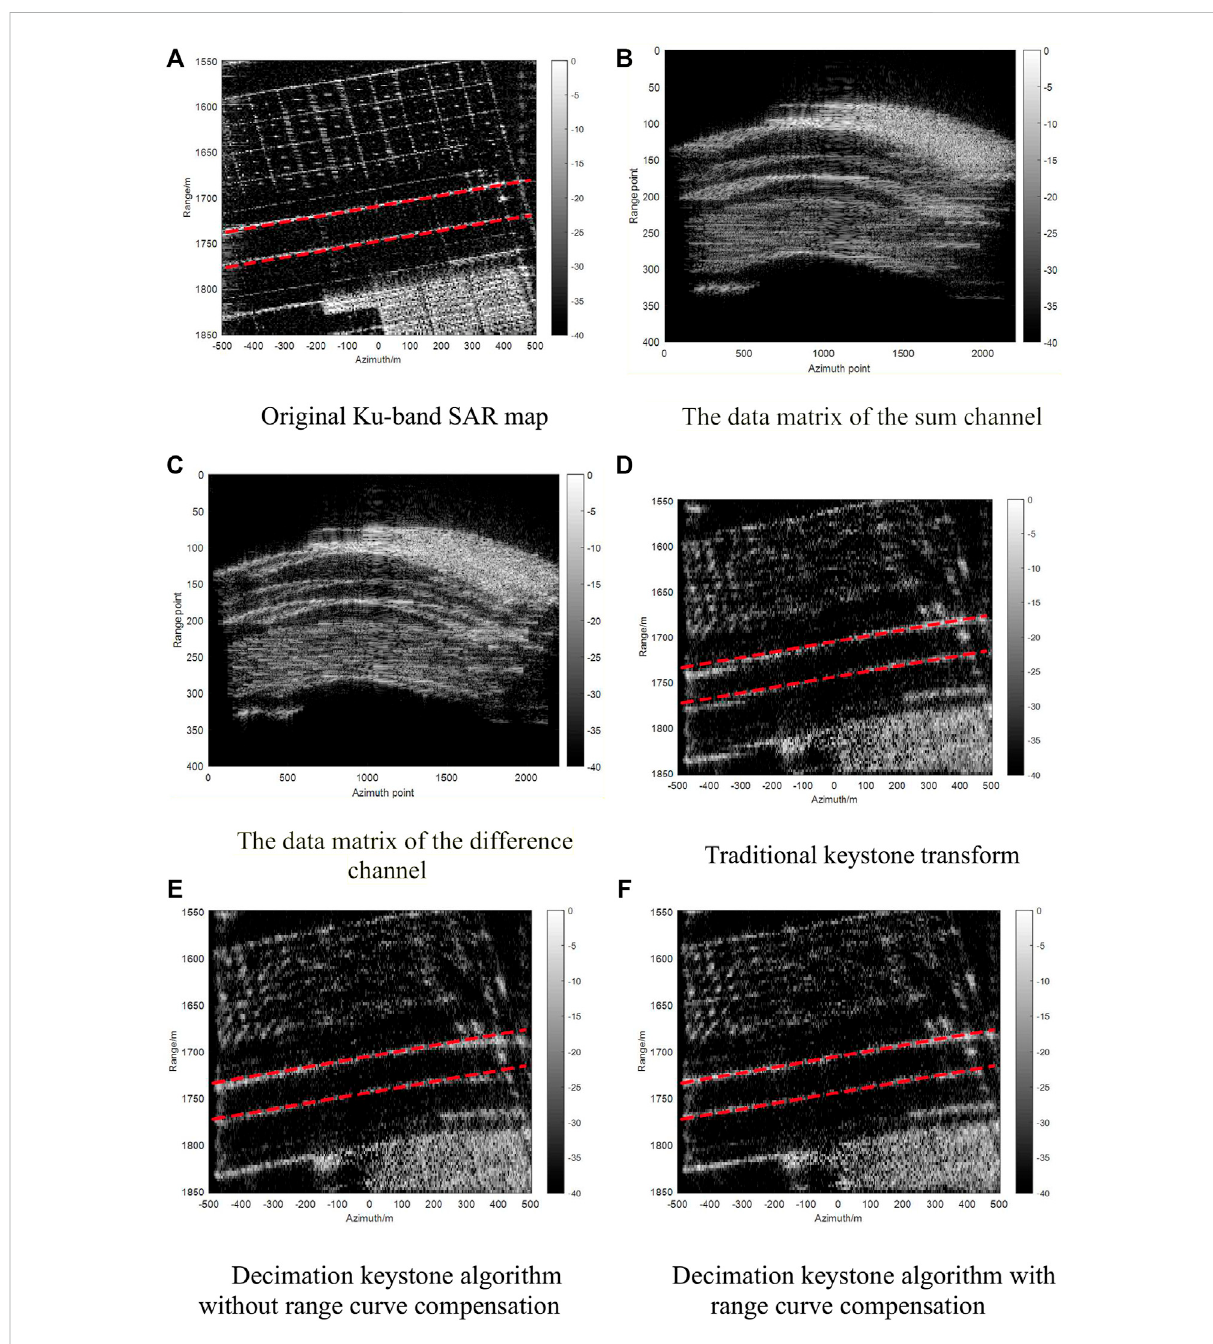
FIGURE 8 Comparison of correction results in simulation scenes. (A) Original Ku-band SAR map. (B) The data matrix of the sum channel. (C) The data matrix of the difference channel. (D) Traditional keystone transform. (E) Decimation keystone algorithm without range curve compensation. (F) Decimation keystone algorithm with range curve